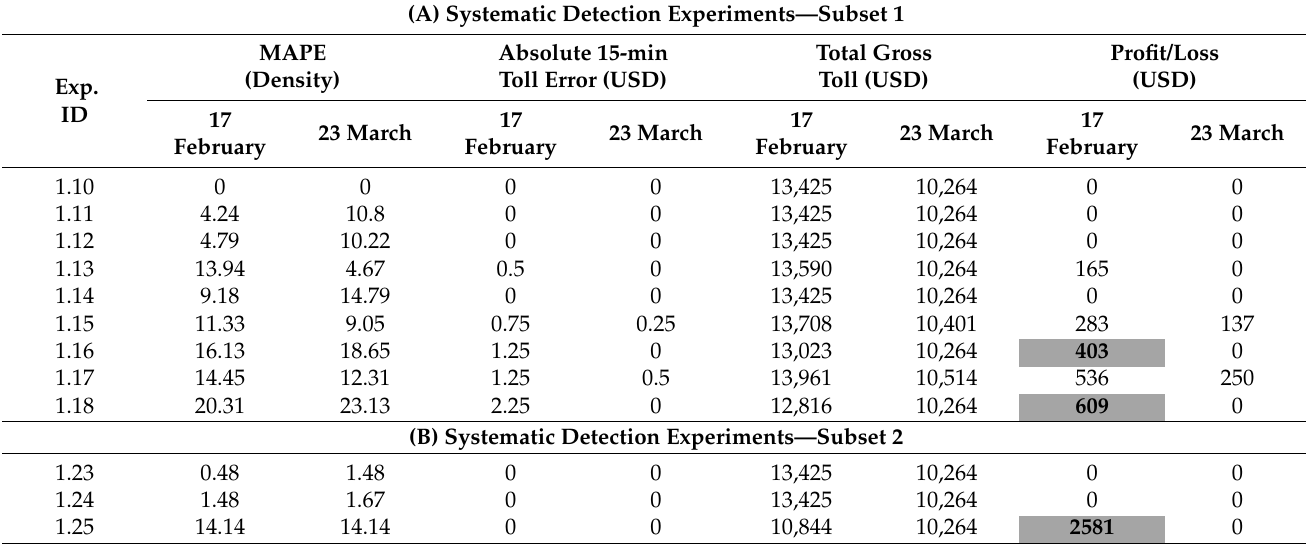
Table 6. Results of systematic detection error scenario for the Northbound segment. (A) Systematic Detection Experiments—Subset 1